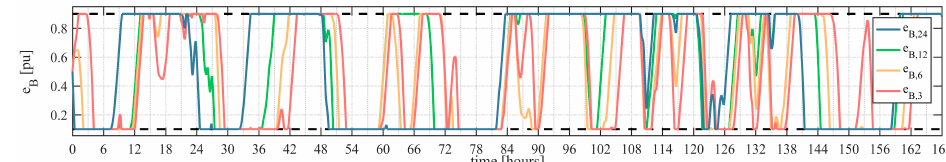
Figure 20. The B energy evolutions achieved by FBM over a generic week by employing different time horizons.